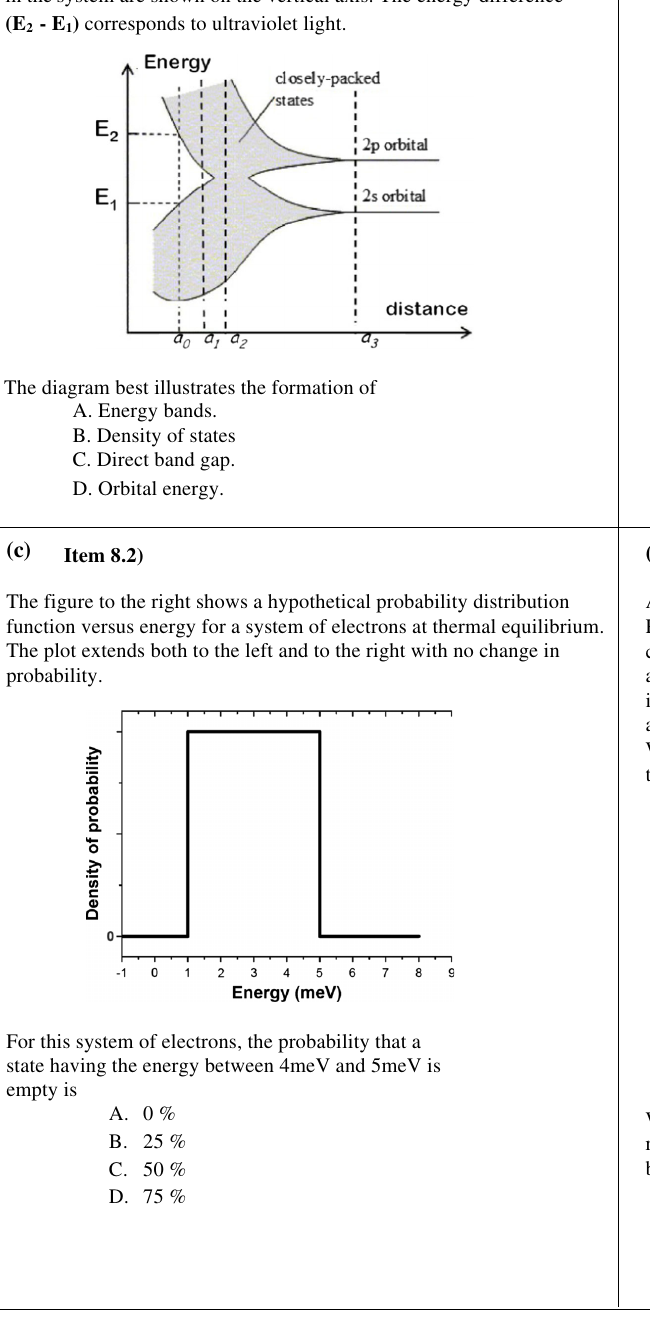
FIG. 3. Four items in the PSCI. (a) An item at application level for the concept category 4 -Energy Bands. The diagram for item 4.1 is an adaptation of the Figure 2.3.2 in Van Zeghbroeck ’ s online textbook (Ref. [54]), (b) An item at application level for the concept category 6 -PN junction I – V plot, (c) An item at application level for the concept category 8 -Statistics, (d) An item at evaluation level for the concept category 7 -Quantum. The cartoon is inspired by the PhET interactive simulation for the “ Photoelectric Effect ” (Ref. [50]). All these items require procedural knowledge: to translate verbal constraints into mathematical language and to interpret diagrams and